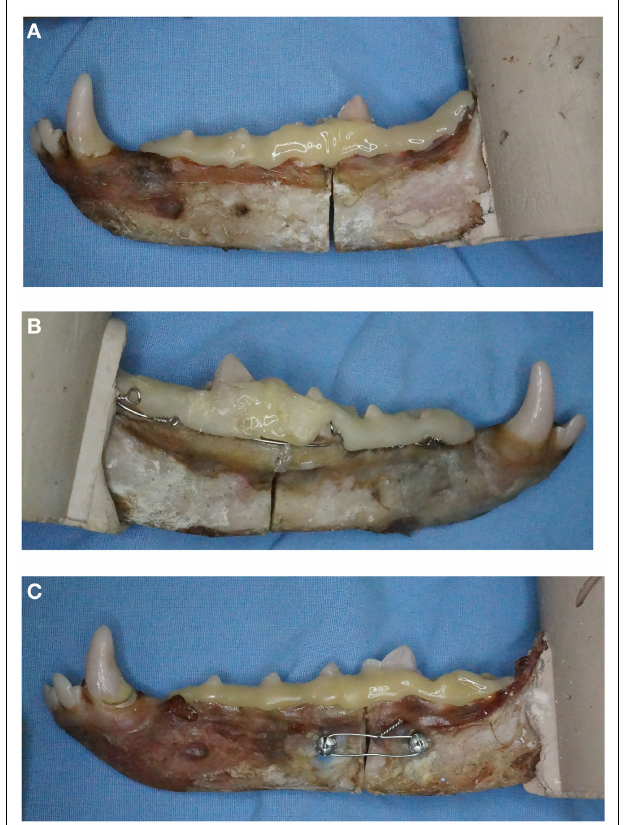
FIGURE 1 | (A) One mandible per pair was randomly assigned to undergo removal of mandibular first molar tooth crown to mimic tooth crown loss similar to what occurs with tooth extraction. (B) Maintaining the first molar tooth crown provides an additional anchorage point for fixation proximal to the fracture when using non-invasive fracture repair techniques.